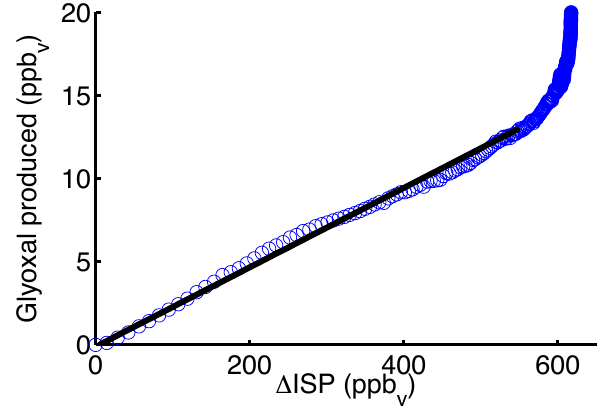
Fig. 2. Glyoxal production as a function of isoprene reacted in Exp.2. Note the linear relationship between glyoxal and isoprene reacted in the first part of the experiment. The continued upward trend in glyoxal after isoprene is consumed corresponds to the for- mation of glyoxal as a higher generation oxidation product. The first-generation glyoxal yield for this experiment is 2.4 ( ±